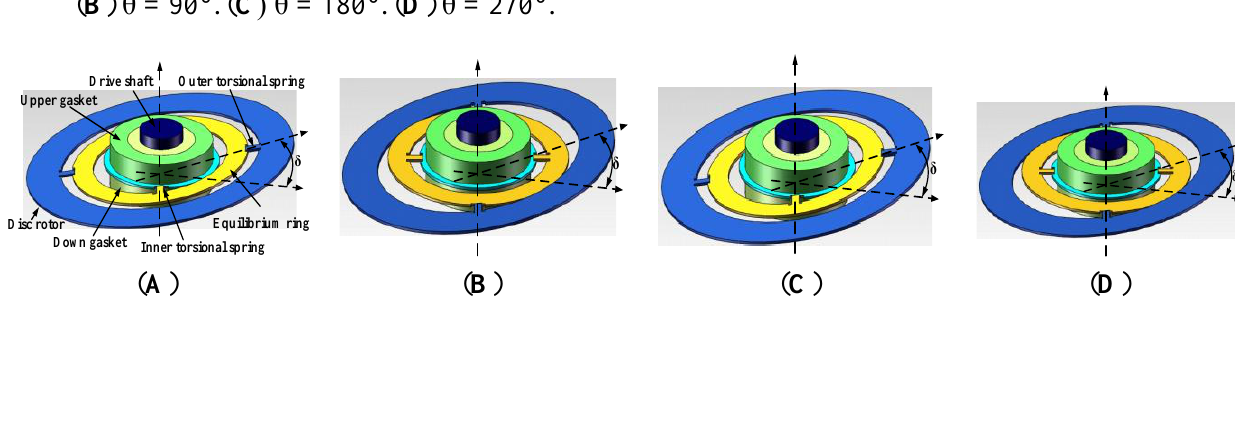
Figure 2. Schematic diagram of torsional motion of disc rotor module. ( A ) θ =